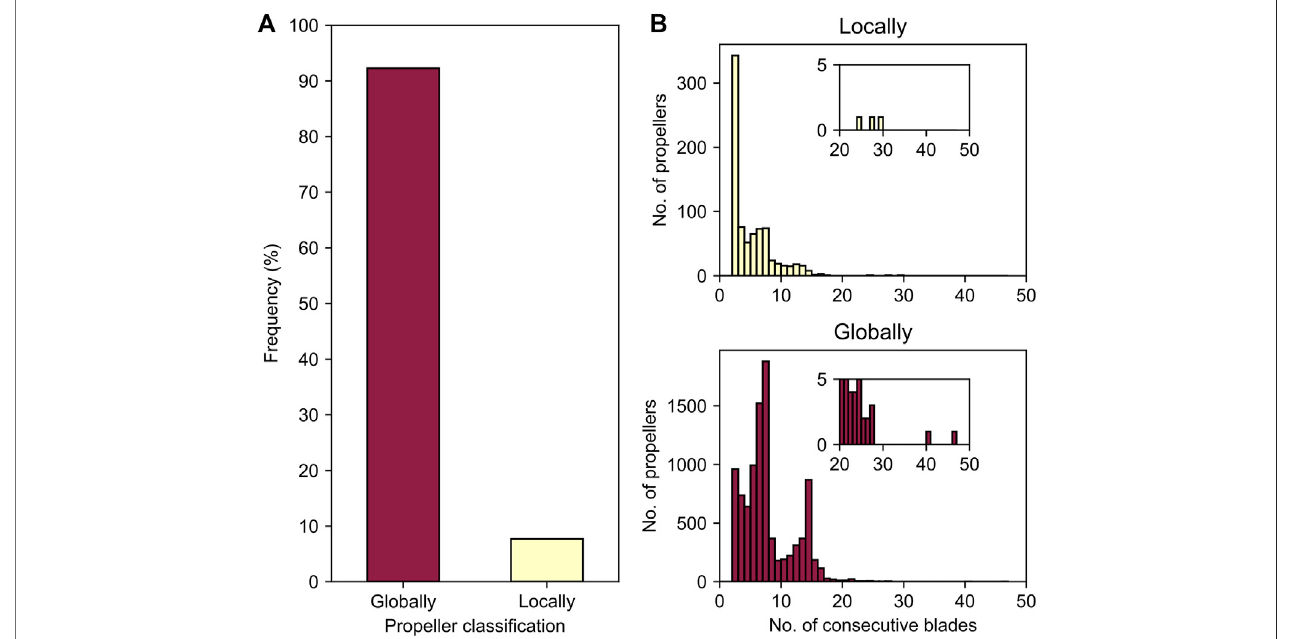
FIGURE4| Globallyversuslocallyhighlyrepetitive β -propellers. (A) Theproportionof β -propellersinthedatasetcategorisedinto “ globally ” or “ locally ” basedonthe absence or presence of non-repetitive β -propeller matches in their immediate domain environment. (B) Histograms for the absolute number of consecutive highly identical blades, separated by highly repetitive β -propeller type.